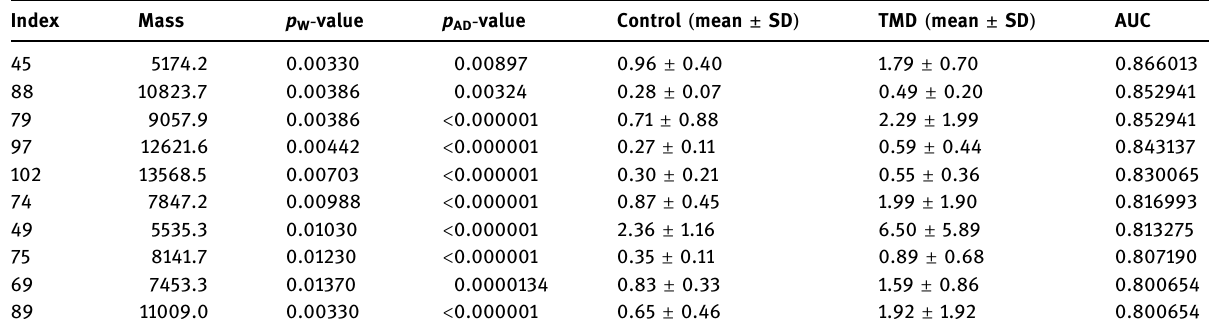
Table 1: ClinProTools peak statistical analyses of the most discriminating polypeptide/protein ions determined in the saliva of TMD patients and the control group